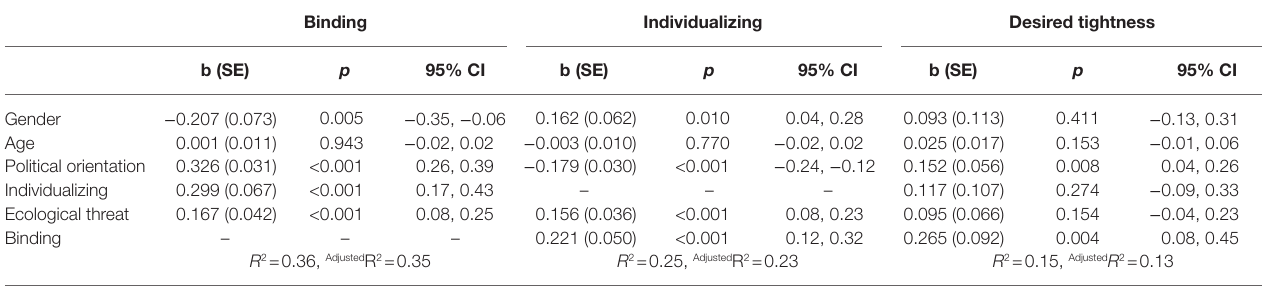
TABLE 6 | Binding foundations and desired tightness regressed on perceived ecological threat, Study 3. Binding Individualizing